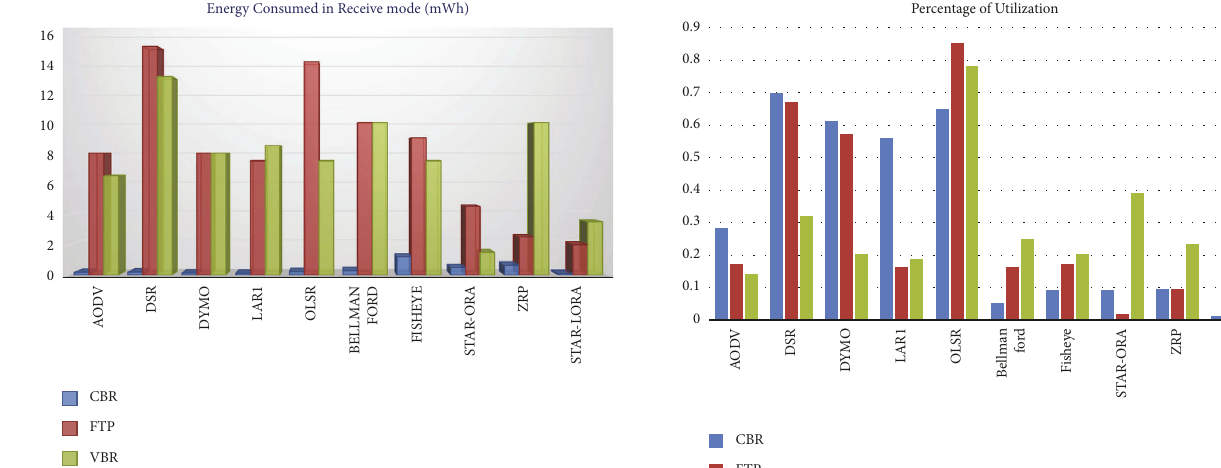
Figure 30: Energy consumed in receive mode of all routing protocols in CBR, FTP, and VBR applications.